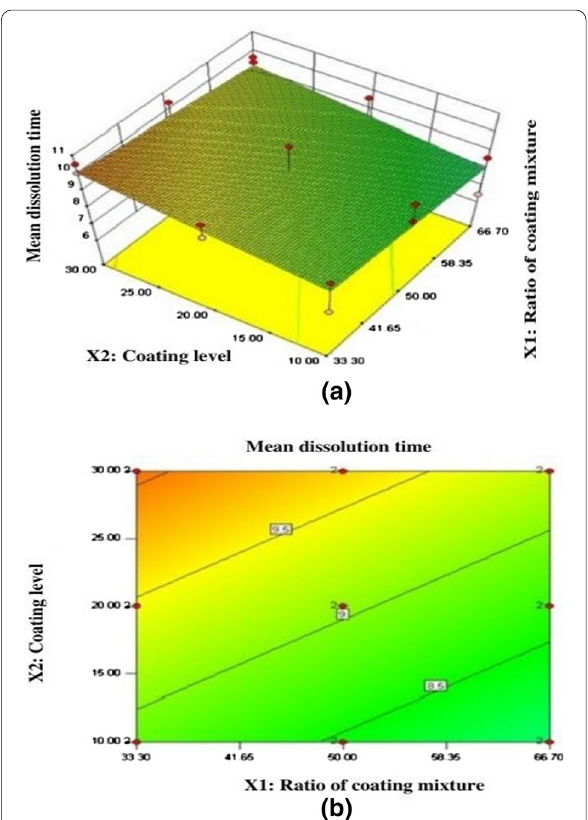
Fig. 7 Response surface method analysis for (Table 2) Y 4 [ a response surface plot & b response contour